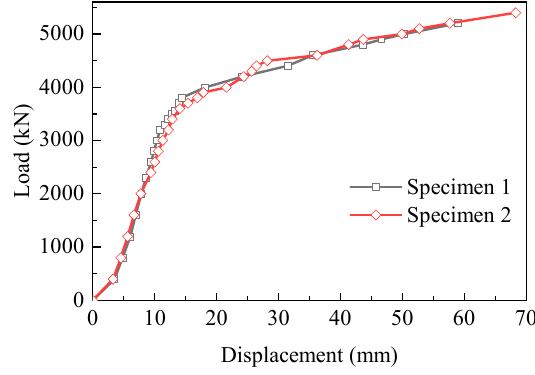
Figure 7. Load–displacement curves of the two specimens. Figure 7. Load – displacement curves of the two specimens.